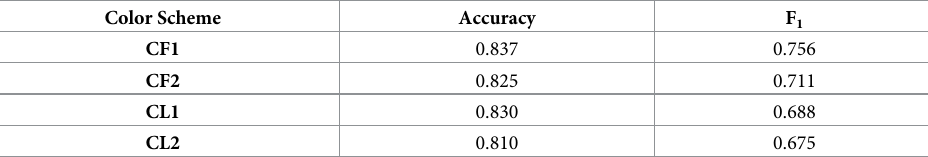
Table 10. The performance of the multi-class classifier using primary and secondary color after dropping the property of color